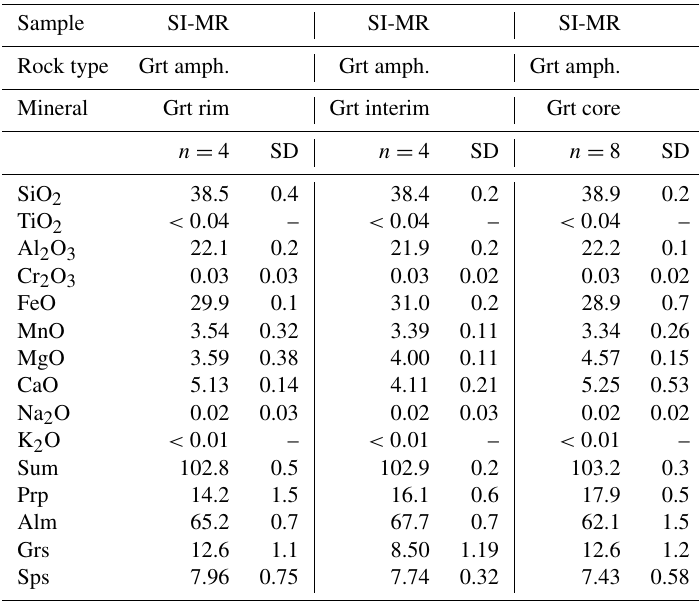
Table 6. Electron microprobe analysis of garnet (average values,